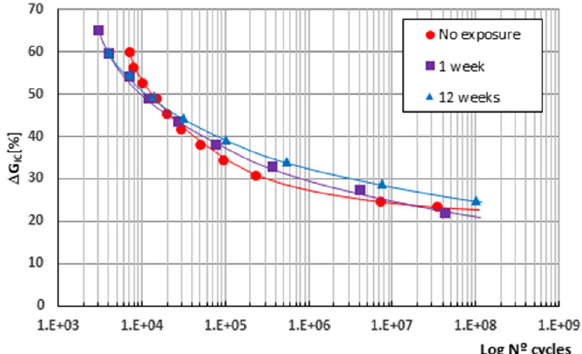
Figure 5. Fatigue behaviour for the three cases studied in function of the stress level.